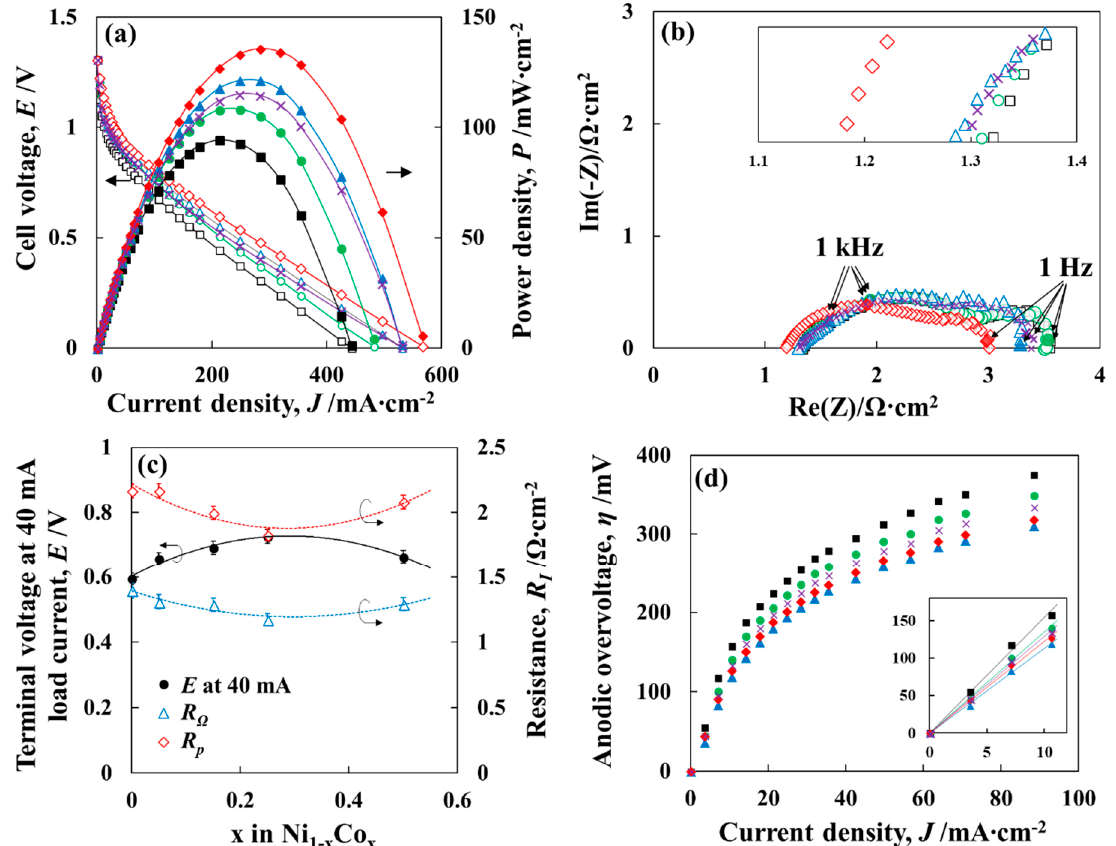
Figure 4. ( a ) Current–voltage curves (open symbols) and power densities (closed symbols), ( b ) electrochemical impedance spectra measured at OCV, ( c ) cell voltage at a constant current, ohmic resistance and the polarization resistance as a function of x, and ( d ) the anodic overvoltages of the Ni 1 − X Co X cell at 750 ◦ C for the CH 4 supply: x = 0 ( (cid:4) , (cid:3) ); x = 0.05 ( (cid:8) , (cid:35) = 0.5 (X). The symbols in Figure 4c are di ff erent from Figure